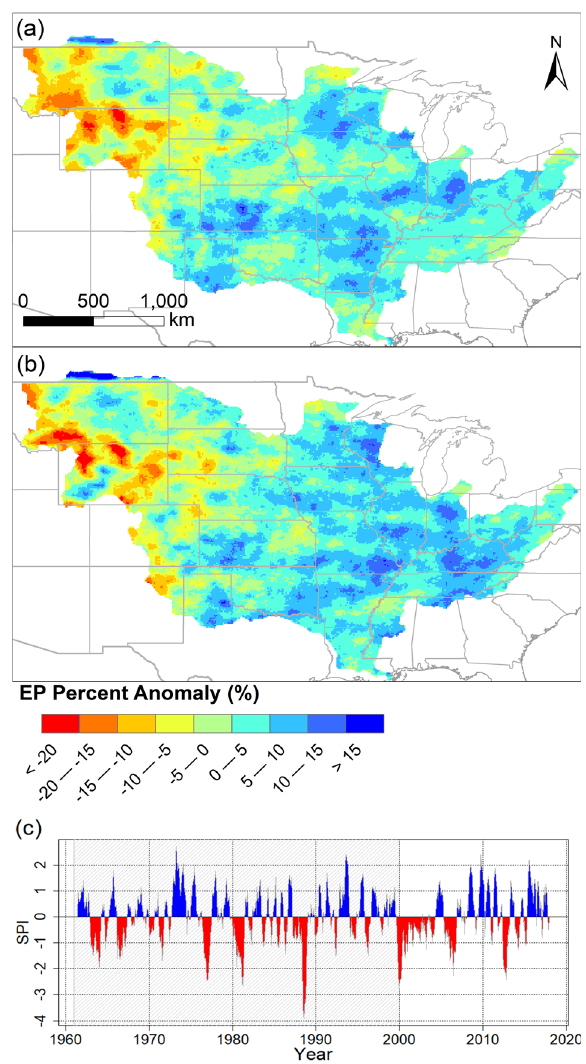
Fig. 2 Extreme precipitation percentage anomaly and drought severity across the Basin. Anomaly of extreme precipitation (EP) percentage to annual total precipitation across the Basin in the 2000s ( a ) and 2010s ( b ) relative to the period 1980 – 1999, and 24-month SPI (standard precipitation index) in this region during 1960 – 2017 ( c ). The 24-month SPI shows that the entire Basin experienced a persistent drought from late 1999 to 2005, and 2007 –